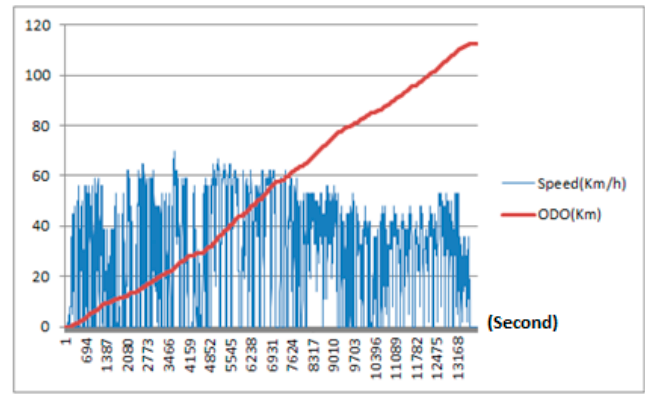
Figure 11. Histories of battery voltage and current.